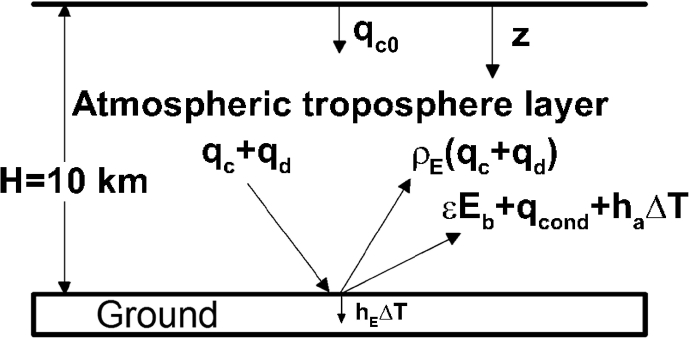
The physical model and coordinate system [1].